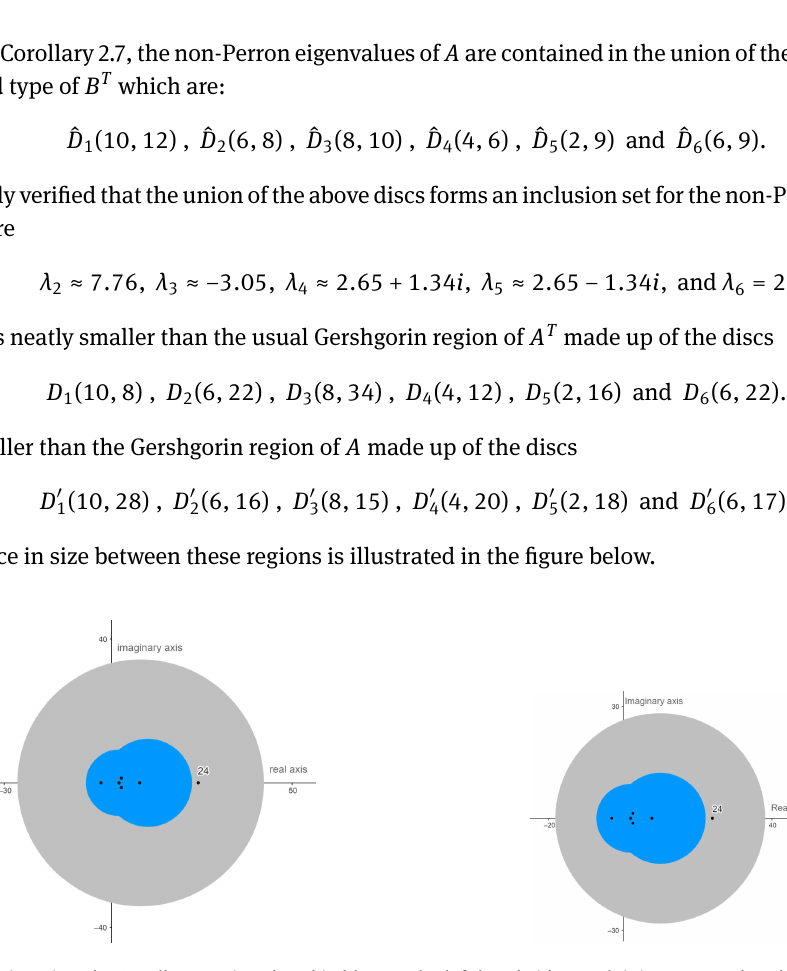
Figure 1: The region given by Corollary 2.7 is colored in blue. In the left hand side graph it is compared to the Gershgorin region of A T and in the right hand side graph it is compared to the Gershgorin region of A . The eigenvalues of A are represented by the small dark points. Observe that all the non-Perron eigenvalues of A are inside the blue region. This is in accordance